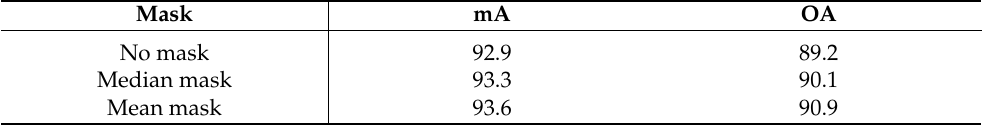
Table 3. Effect of different masking mechanisms on point cloud classification